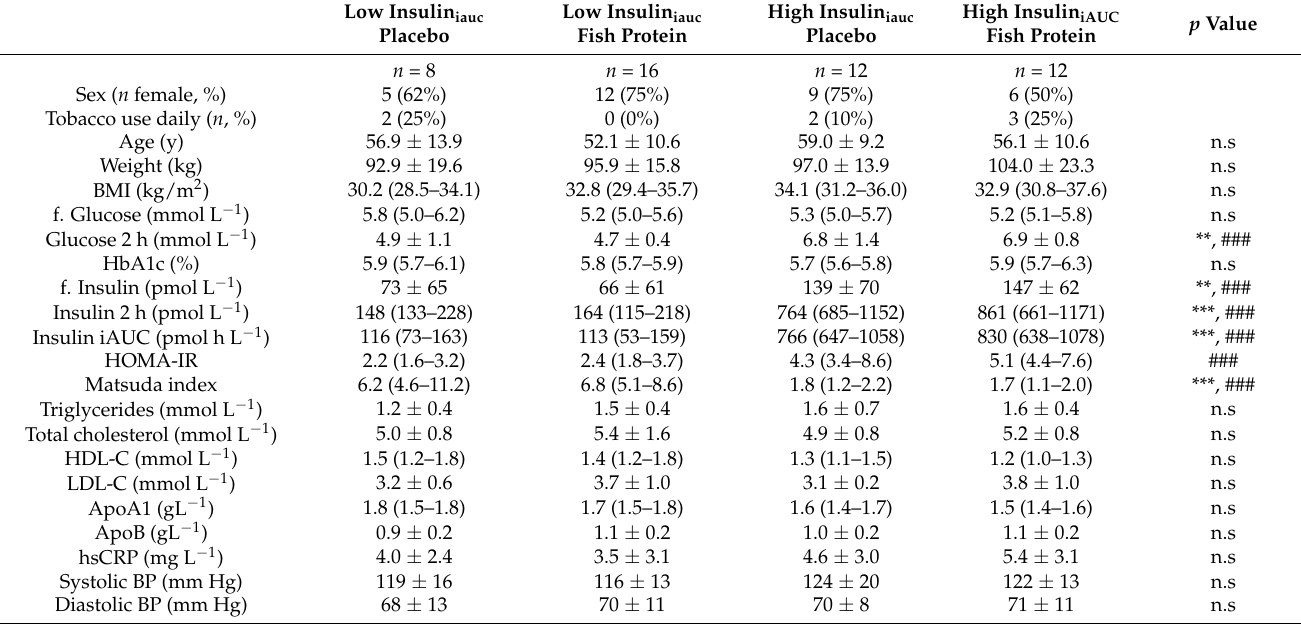
Table 4. Anthropometric and biochemical characteristics of the study population in the different intervention